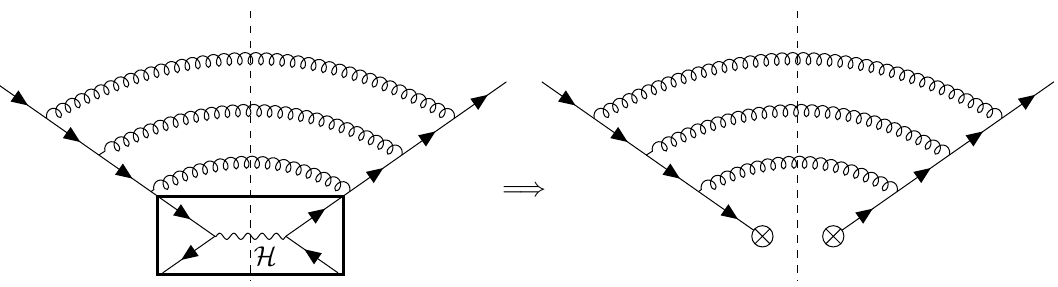
Figure 2 . Sketch of a squared diagram from the RRR contribution of q ¯ q → V + ggg (left-hand side) and the same contribution to the partonic beam function where the hard process ( H ) has been replaced by a projector denoted by the crossed dots (right-hand side). The dashed vertical line represents the final state cut. The Feynman rules used for the projector are explained in the main